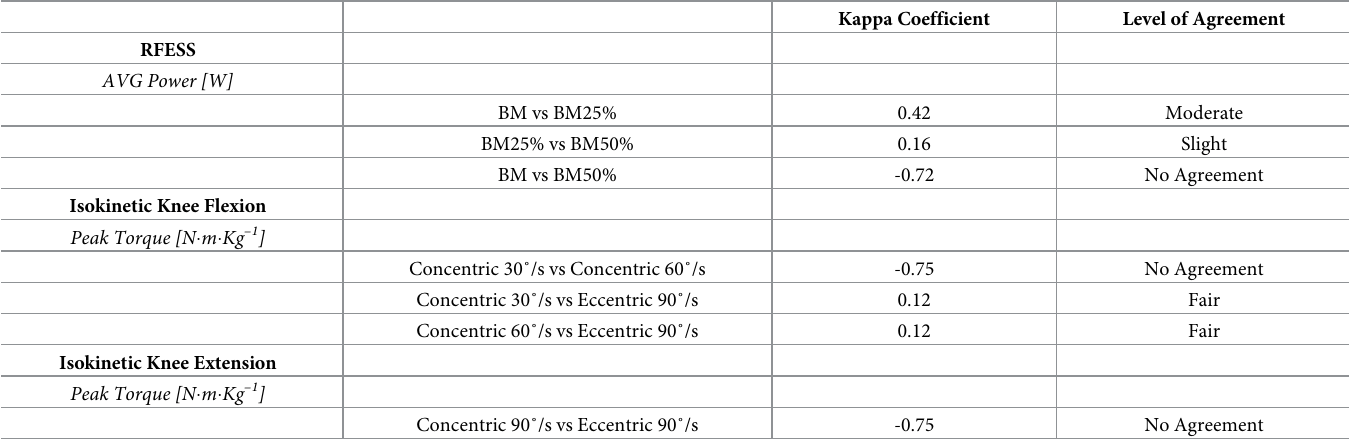
Table 2. Kappa coefficients and descriptive levels of agreement showing how consistently inter-limb asymmetry favors the same limb within the same